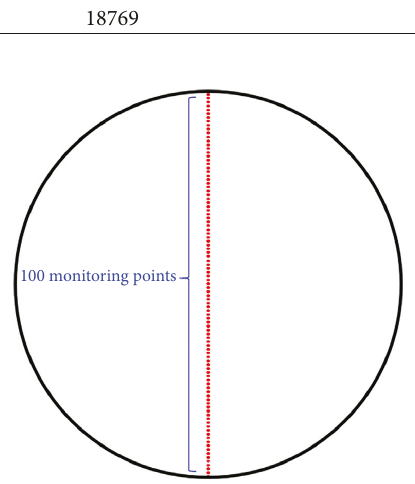
Figure 6: Arrangement of monitoring points in cross section at the exit.